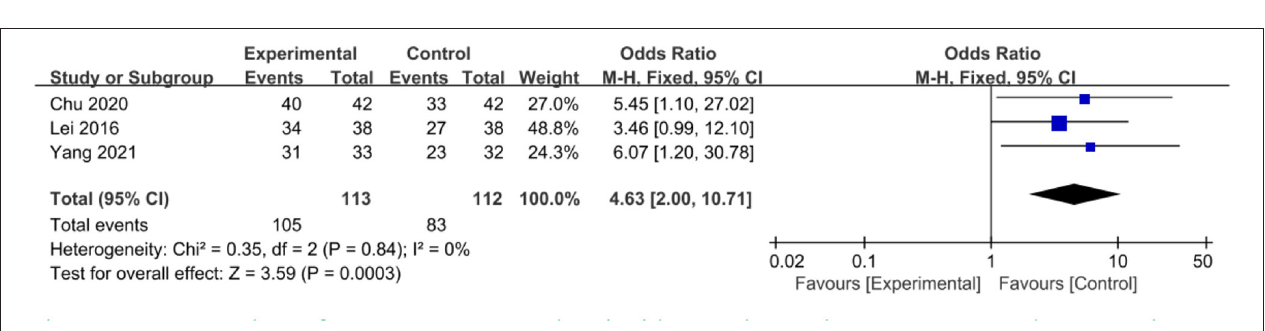
FIGURE 23 | Forest plots of response rate associated with experimental group (parenteral or enteral nutrition group supplemented with Gln) vs. control group (conventional nutrition group). I 2 tests and P are the criteria for the heterogeneity test, (cid:7) , pooled odds ratio; — (cid:4) —, odds ratio, and the edges of (cid:7) , 95%